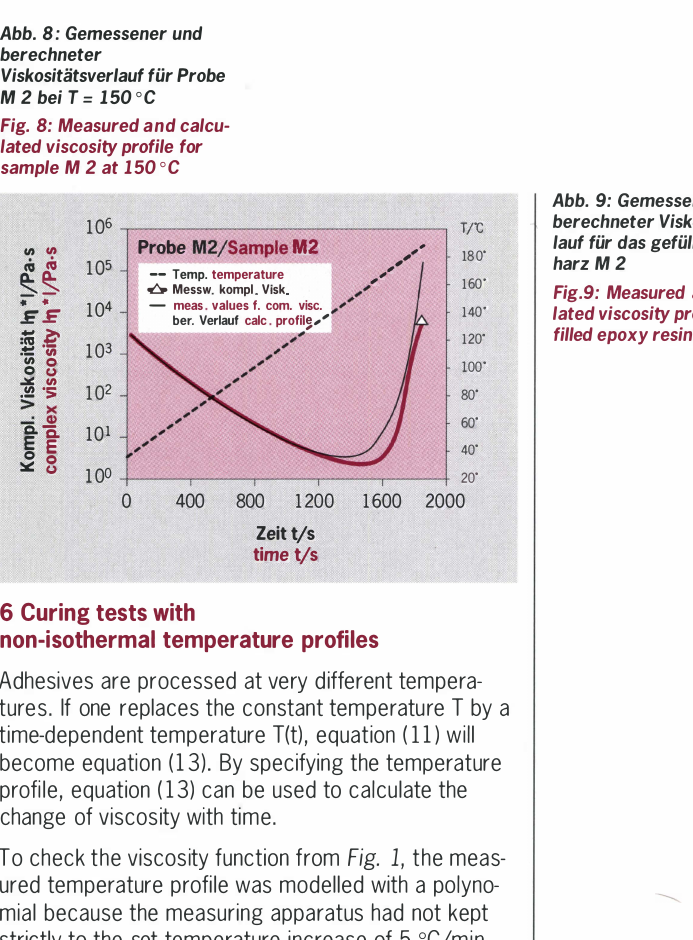
Fig. 8: Measured and calcu­ lated viscosity profile for sample M 2 at 150 oc 10 6